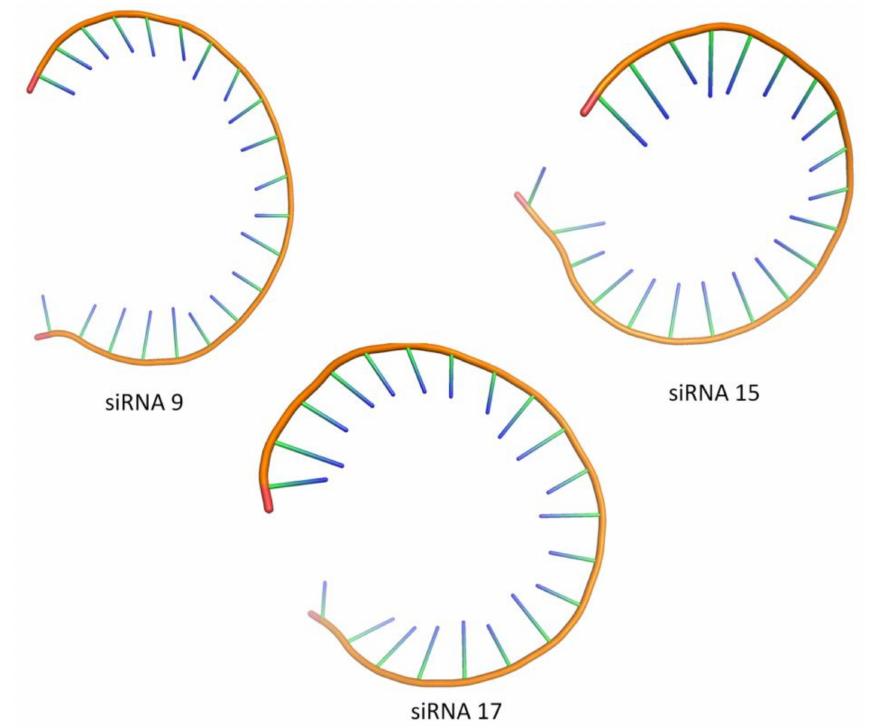
Figure 3. Tertiary structures of siRNA 9, siRNA 15, and siRNA 17. The validity of the tertiary structures of these siRNAs had been classified as “acceptable” on the basis of the analyzed criteria for nucleic acid